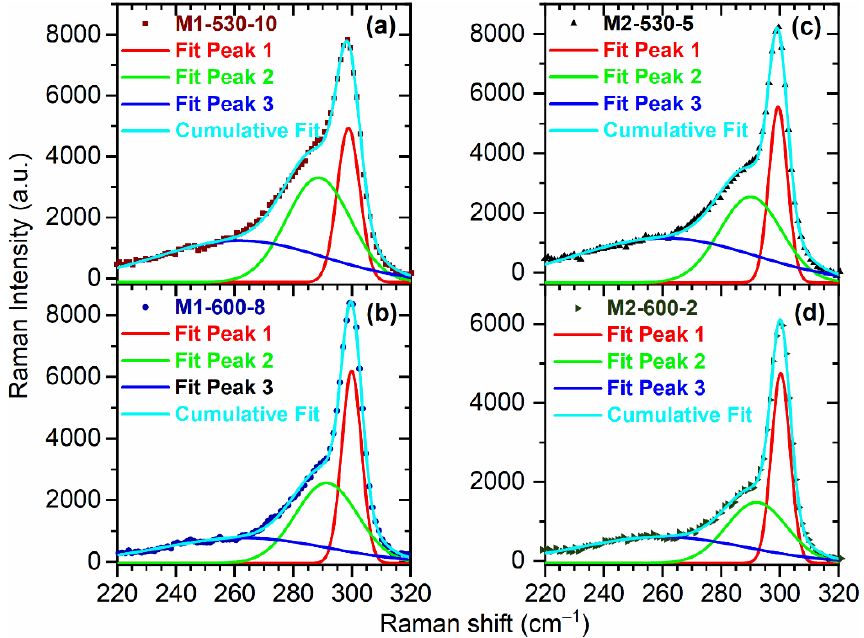
12.5% at the interface of floating gate with adjacent HfO 2 layers . The last Peak 3 (blue), prac- tically a low-intensity broad band centered at about 260 cm –1 corresponds to low ordering, i.e., formation of clusters or amorphous SiGeSn nanoparticles [25].